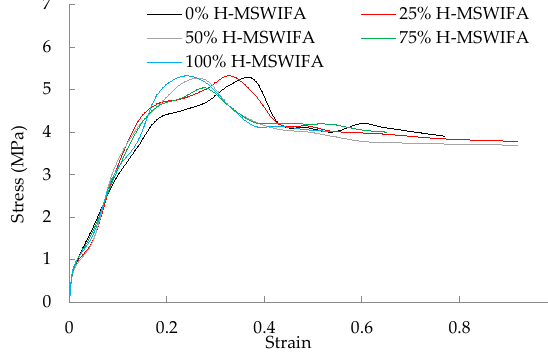
Figure 9. FSFE curve of asphalt mastic at F/A of 1.0.